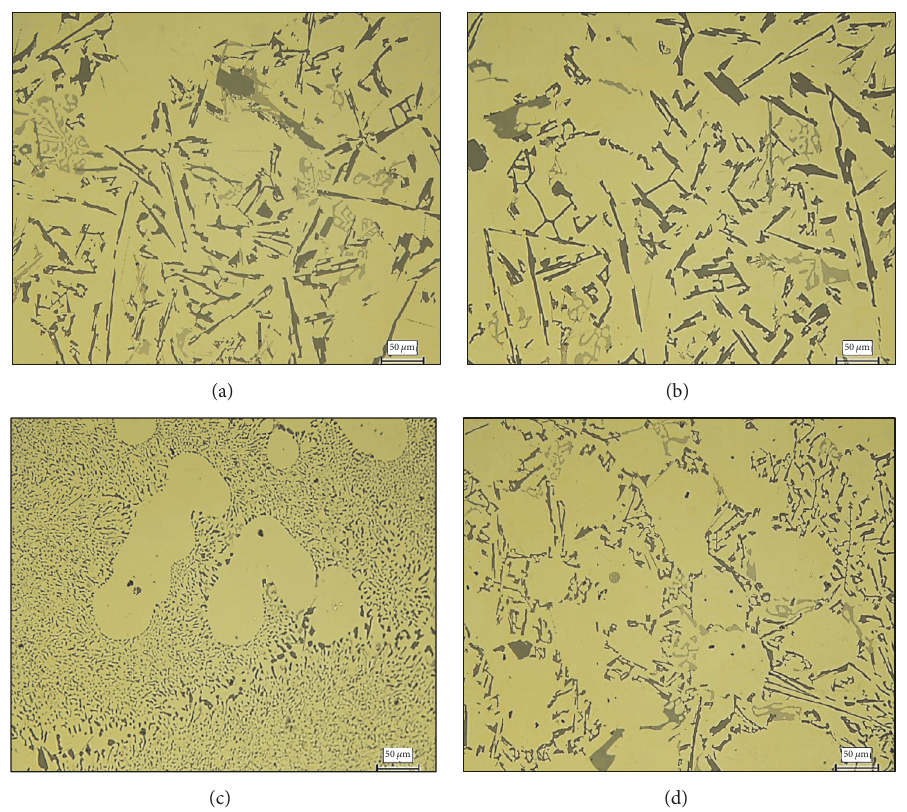
Figure 6: Variation in the eutectic Si morphology as a function of melt treatment: (a) no addition, (b) addition of 3% RE (alloy #11 in Figure 4(a)), (c) modification with 100ppm Sr, and (d) addition of 2% RE to Sr-modified alloy (alloy #10 in Figure